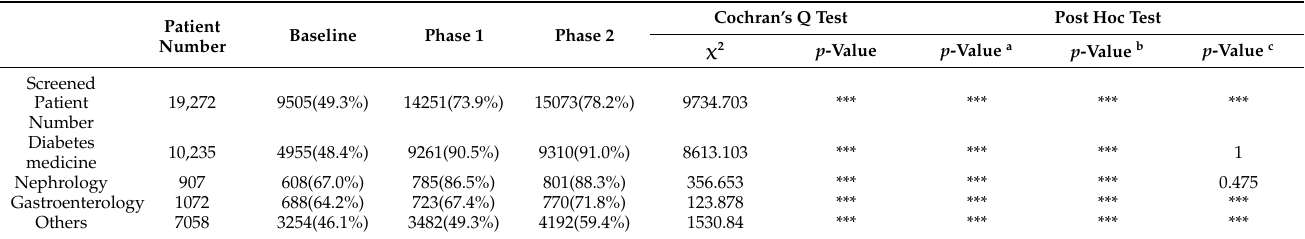
Table 1. Comparison of screening rates at different time points according to the outpatient